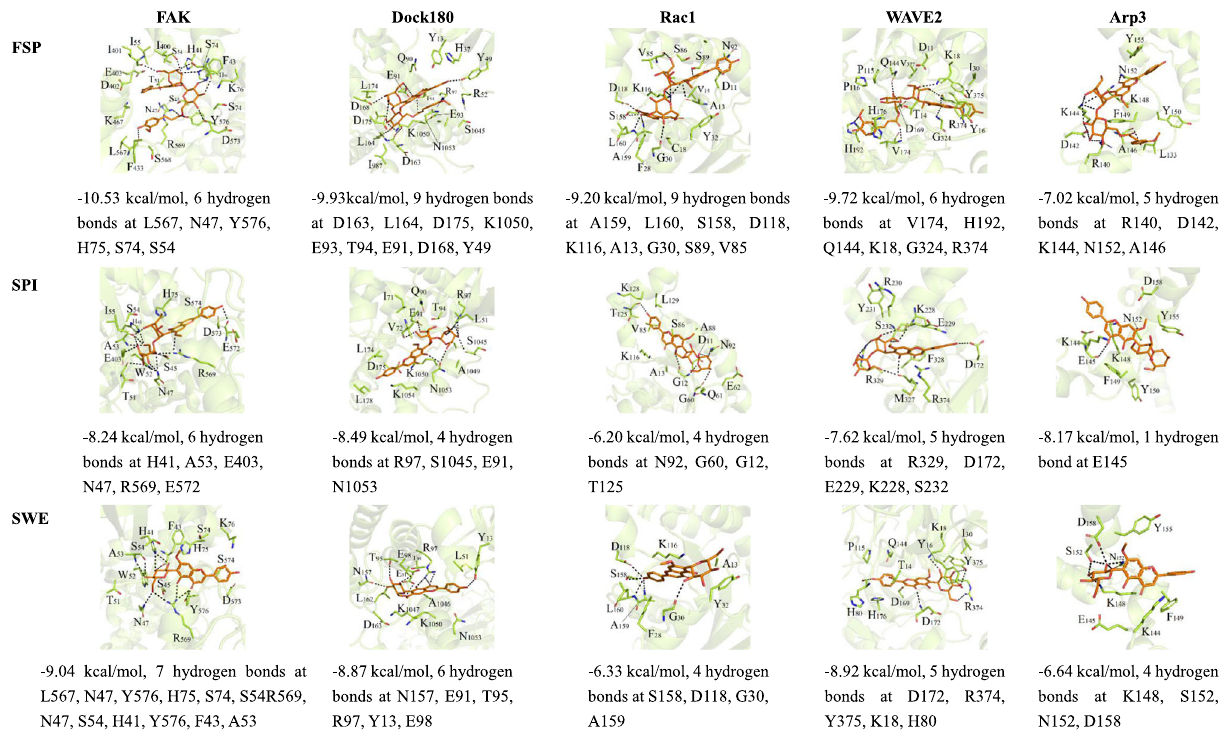
Fig. 5 Interaction modes of 6'''-feruloylspinosin (FSP), spinosin (SPI), and swertisin (SWE) with the binding pocket of FAK, Dock180, Rac1, Arp3, WAVE2. The black-dashed lines indicate hydrogen bonds with the residues in the binding cavity of